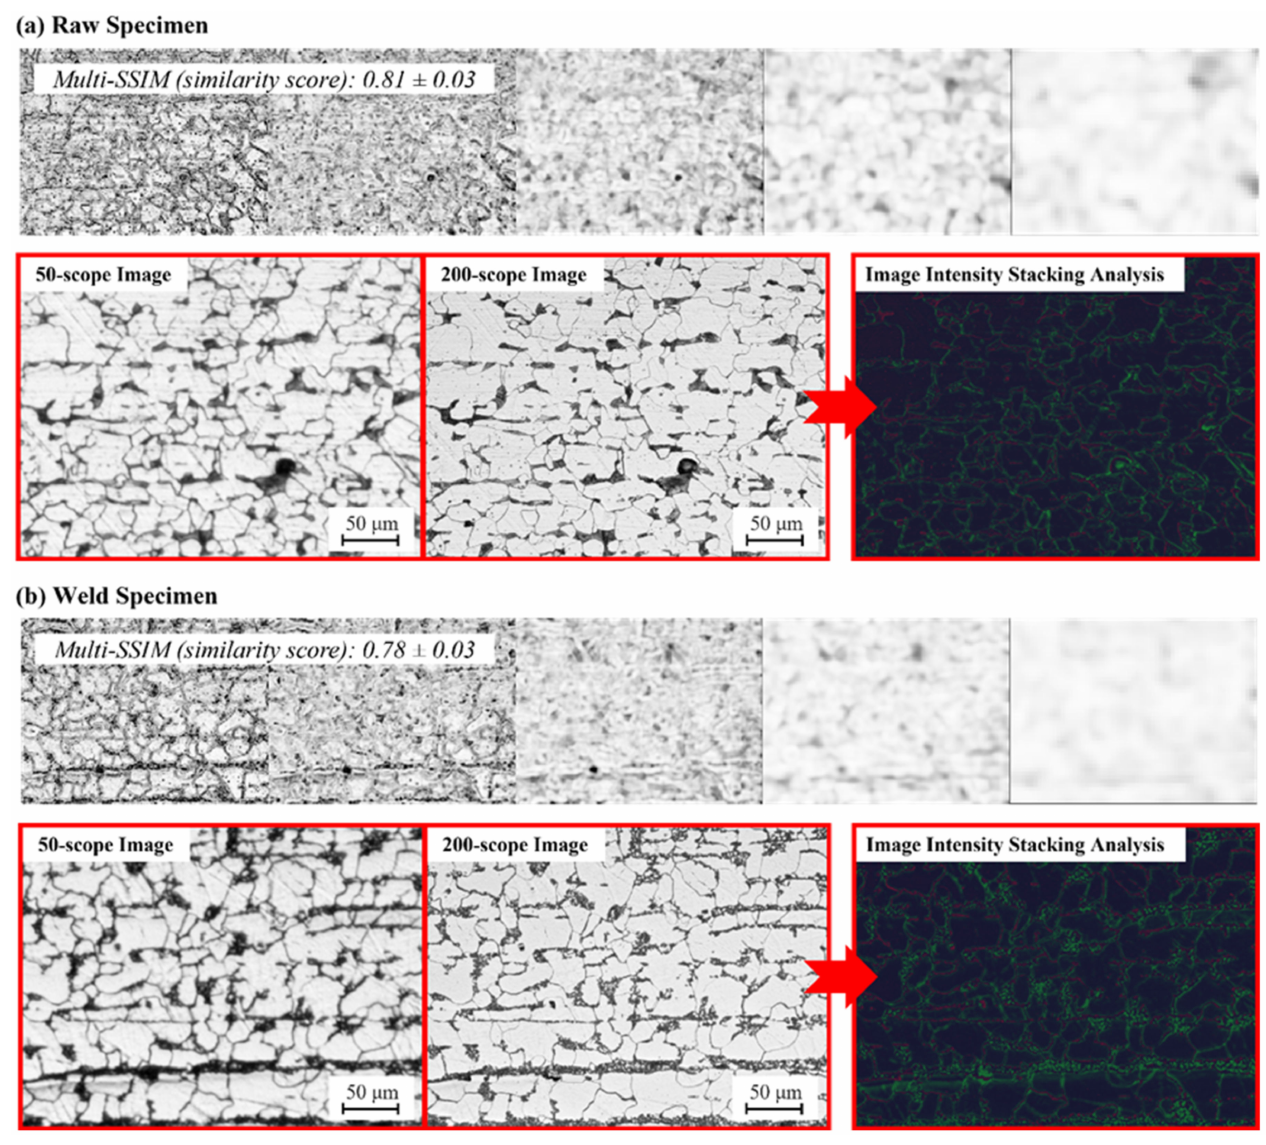
Figure 12. Linear regression model analysis based on least-squares methods for assessing the model performance and